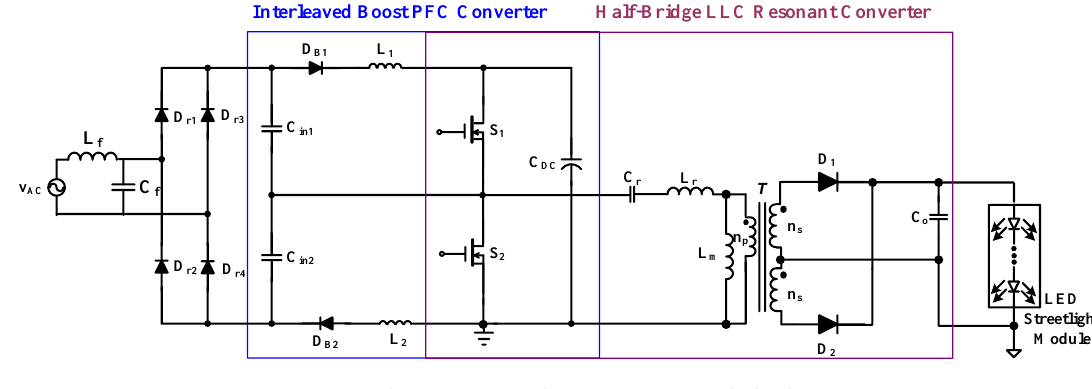
Figure 1. The existing single-stage LED streetlight driver.